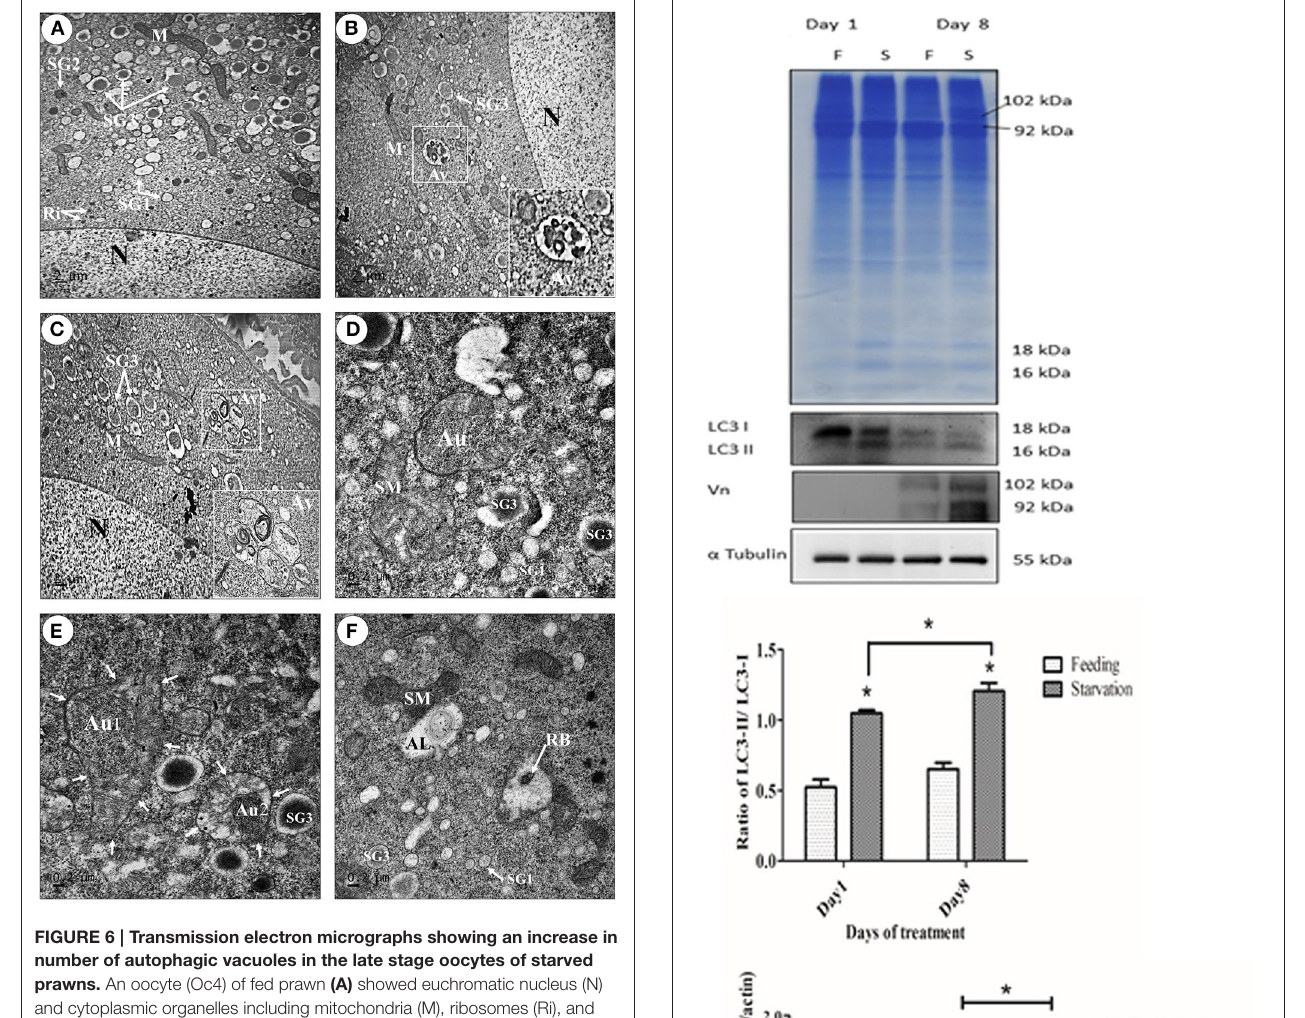
rapid maturation process following starvation, as